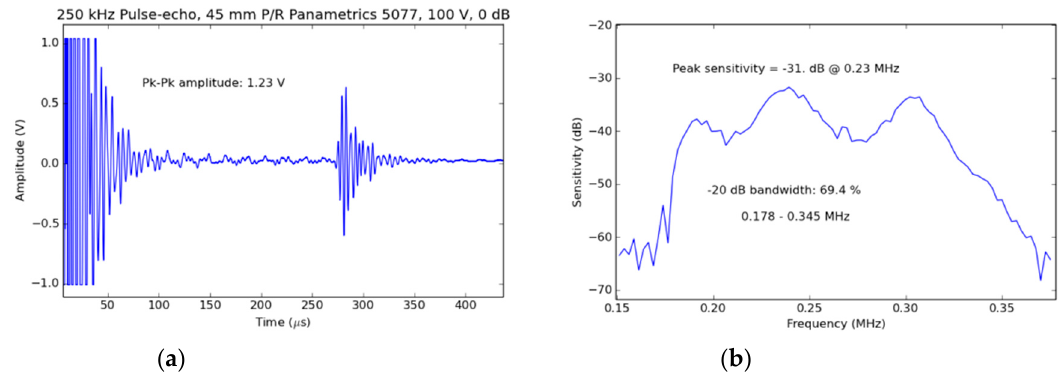
Figure 1. Transducer impulse response in the time domain V RX (a) and sensitivity frequency band SNS (b) in pulse-echo (PE) mode. The FFT was obtained from V RX in a temporal window between 250 and 450 µs.